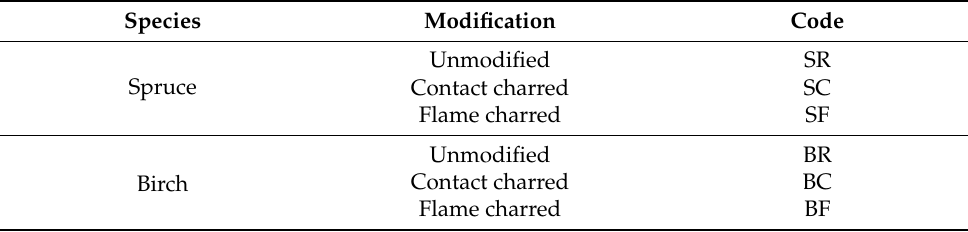
Table 1. Coding for species and modification.